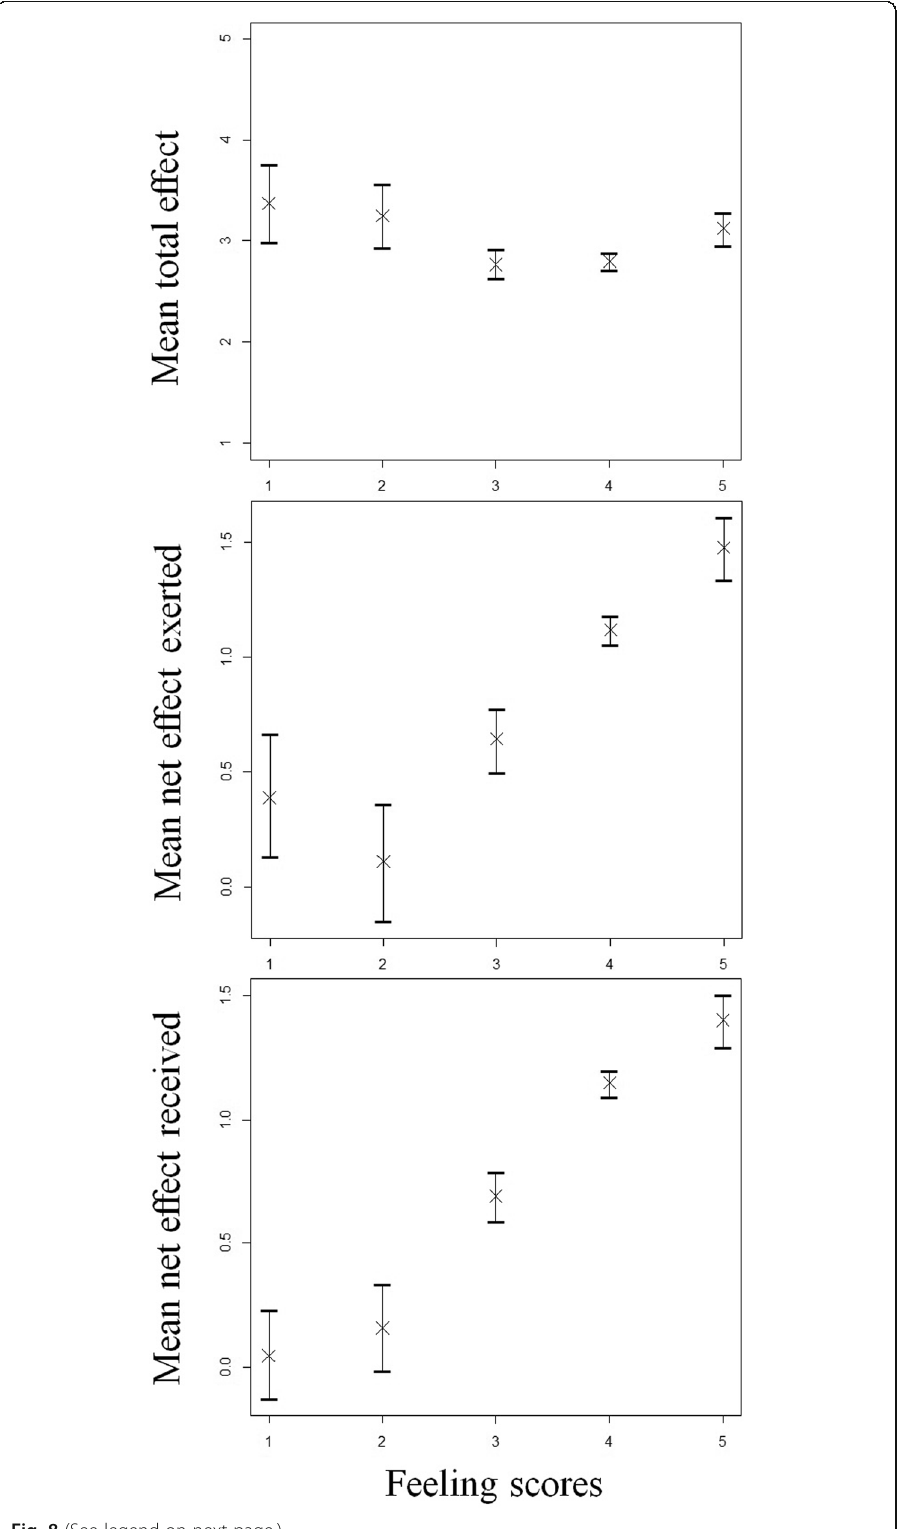
Fig. 8 (See legend on next